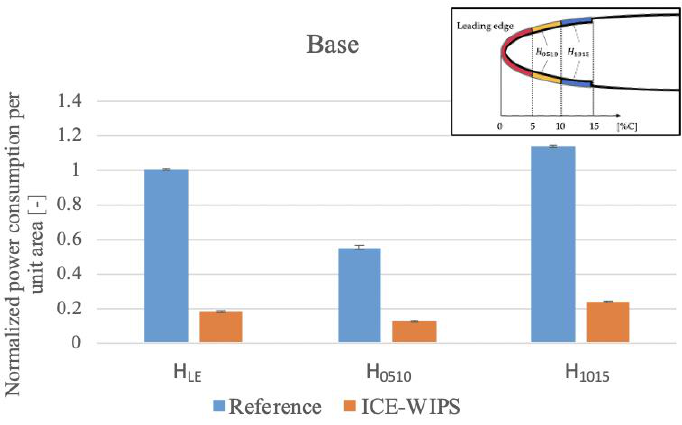
Figure 8. Normalized power consumption per unit area of each heating area for Base case.